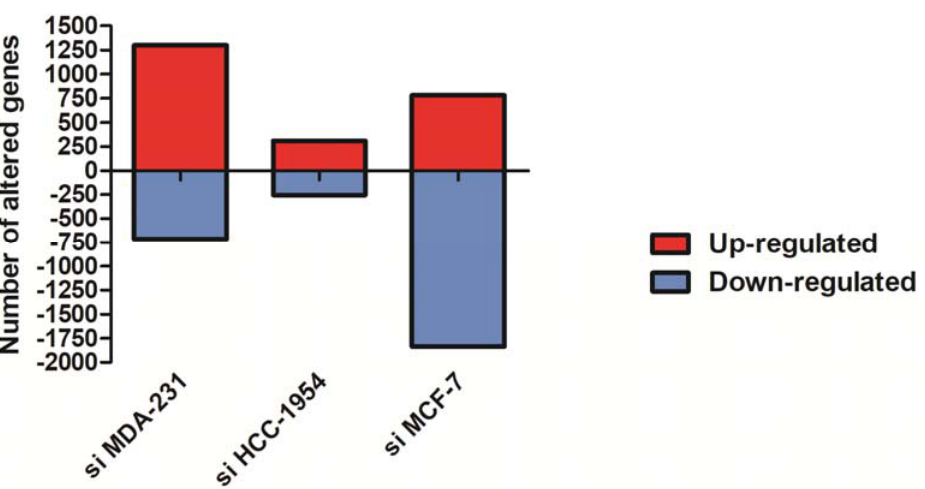
Figure 1. Differentially expressed genes identified by the chip array assay showing increased and decreased genes in breast cancer cells with silenced nuclear factor-kappa B (NF- κ B)/p65 compared with their scramble counterparts. Positive values (red columns) correspond to the number of up-regulated genes, and negative values (blue columns) correspond to the number of down-regulated genes.